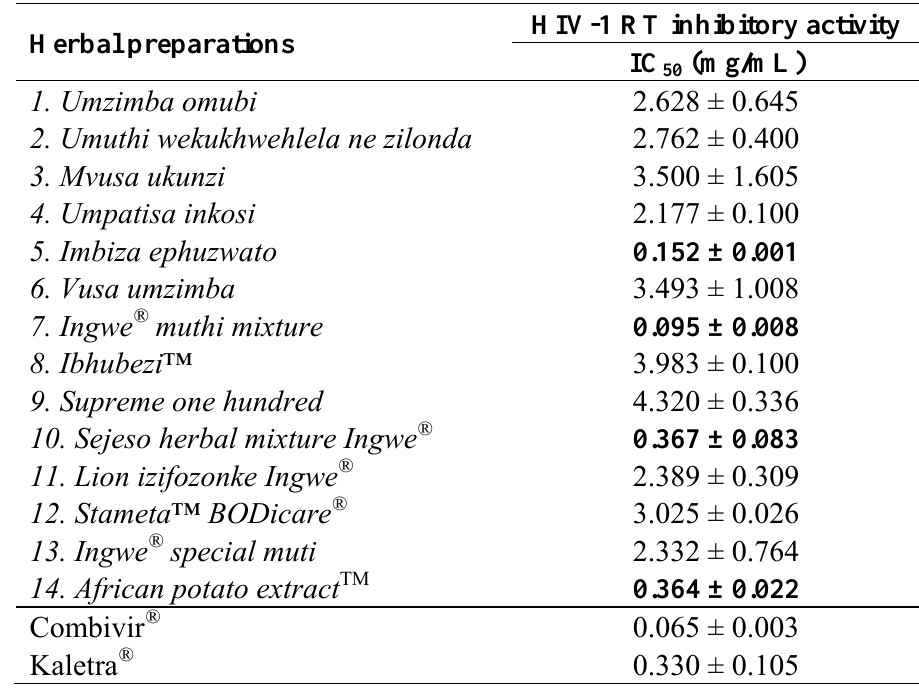
Table 3. HIV-1 RT inhibitory activity (IC Pietermaritzburg,